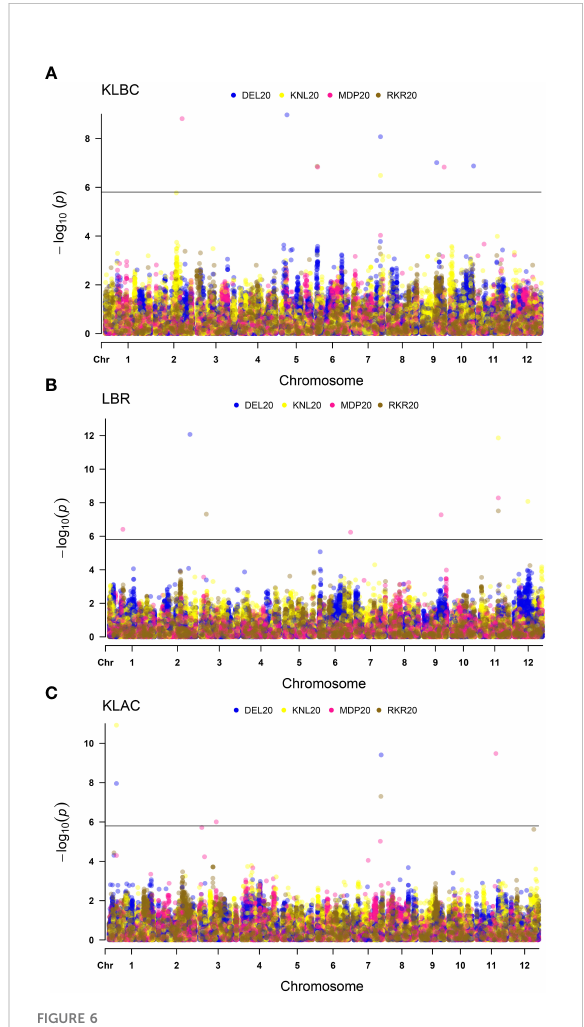
FIGURE 6 Multi-Environmental Manhattan plots depicting signi fi cant MTAs for various grain quality traits viz . (A) Kernel length before cooking (KLBC), (B) Length-Breadth Ratio (LBR) and (C) Kernel length after cooking (KLAC). The dots marked in different colours indicate QTNs detected in different environment. The horizontal line indicates Bonferoni